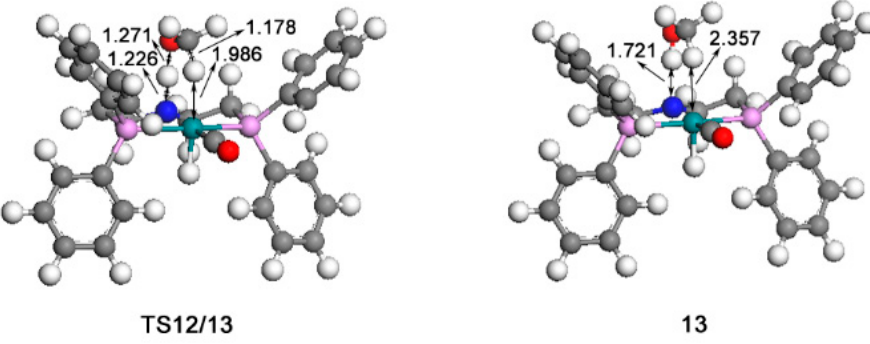
Figure 8. Optimized structures of TS12/13 (735 i cm − 1 ) and 13. The unit of bond lengths is expressed in angstrom (Å). (Green balls: Ru; pink: P; red: O; blue: N; grey: C; white: H).